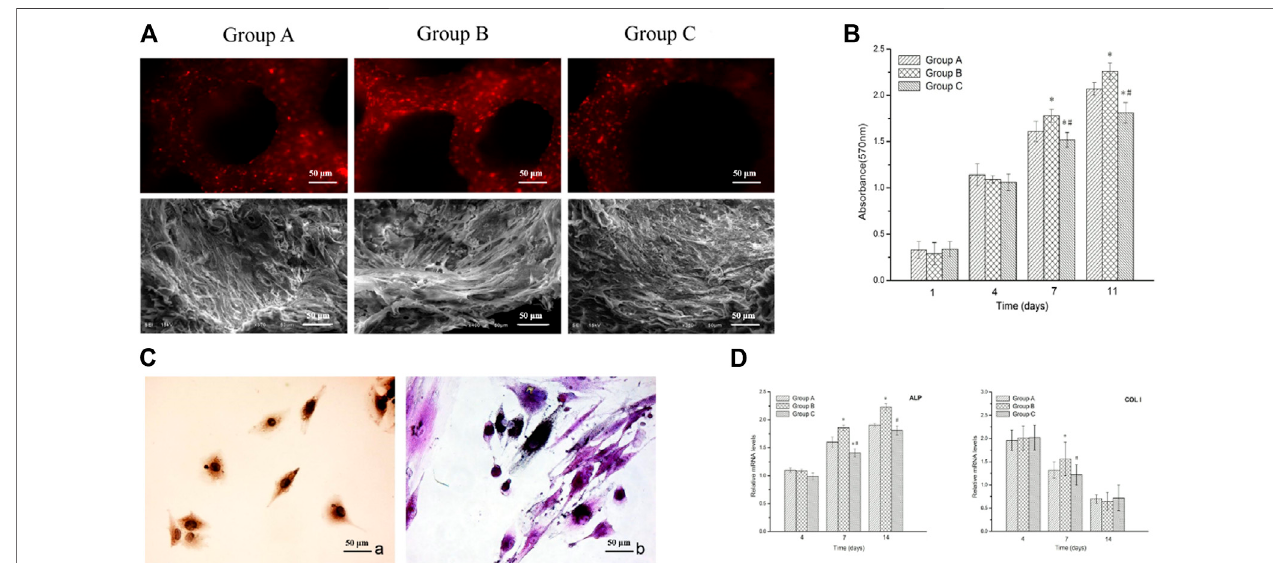
FIGURE 3 | Biocompatibility of n-HA/PA66 scaffolds. (A) Fluorescence microscopy and SEM micrographs show the DiI-labeled cells attached to the three groups of n-HA/PA66 scaffolds at 7 days after being seeded in vitro . (B) MTT assay for the proliferation of BMSCs at various incubation periods combined with three types of n-HA/PA66 scaffolds under the same culture condition. (C) Positive ALP staining and Positive COL I staining. (D) Relative mRNA expressions of ALP and Col-1 by BMSCs cultured on the three groups n-HA/PA66 scaffolds for 7 and 14 days * indicates signi fi cant difference from group A ( p < 0.05); # indicates signi fi cant difference from group B ( p <